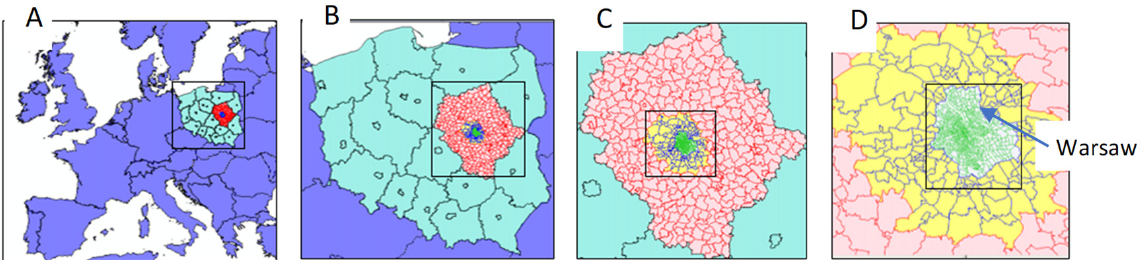
Figure 2. Hierarchy of analysis of the trips related to Warsaw: ( A )-from abroad, ( B )-domestic, ( C )-from the Mazovia region, ( D )-from the Warsaw Metropolitan Area (WMA).